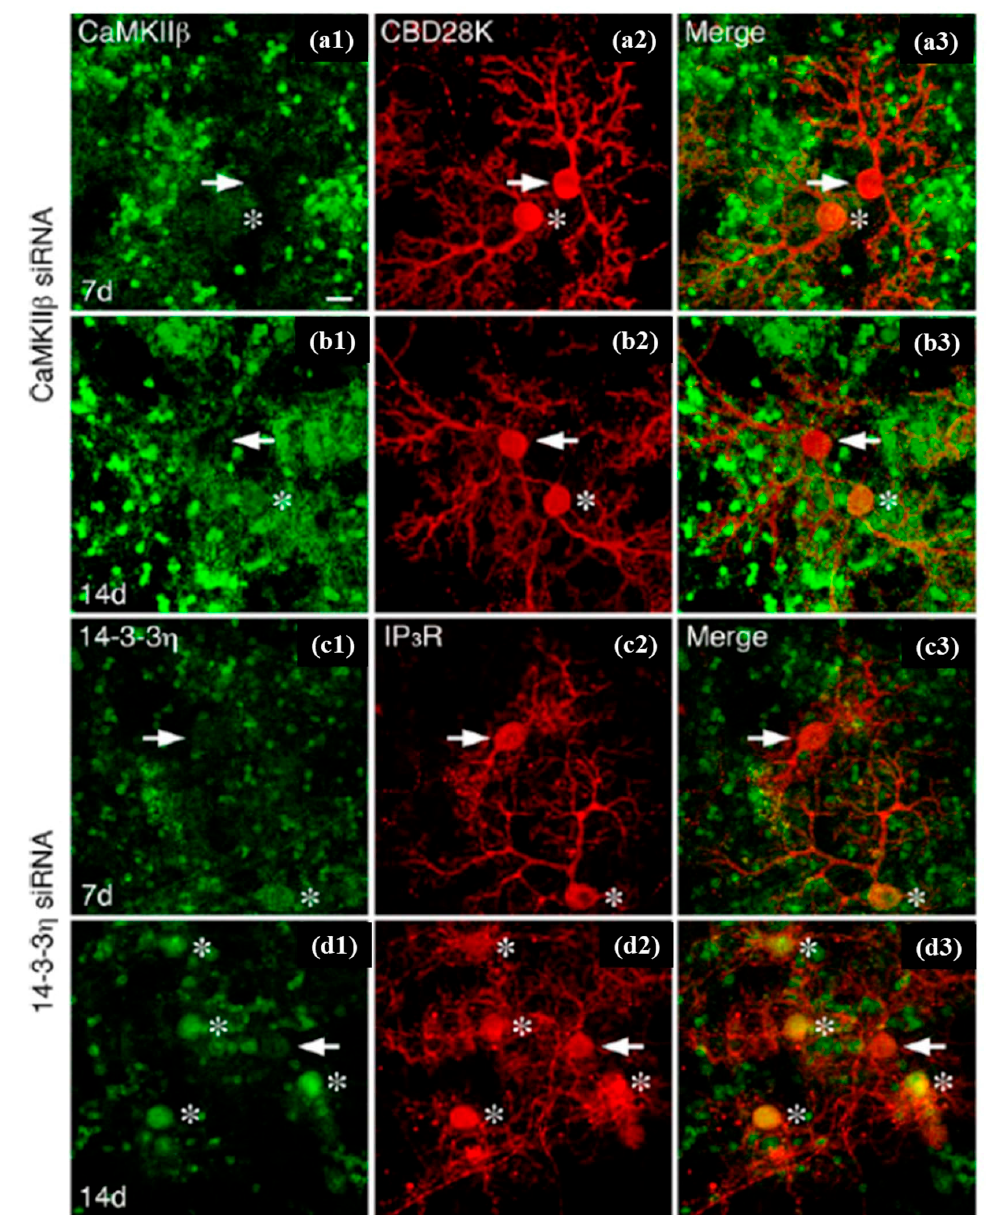
Figure 15. Immunostaining images of single-cell electroporated Purkinje cells small interfering RNA (siRNA) against calcium / calmodulin-dependent protein kinase ß (CaMKIIß) or 14-3-3 η ). SCEP was done at 11 days in vitro (DIV). The cell fixation was performed on day 7 ( a , c ) or day 14 ( b , d ) post electroporation (18 or 25 DIV, respectively) and double fluorescent immunostaining against CaMKIIß (green in a , b ) and calbindin-D-28 K (CBD28K) (red in a , b ) or 14-3-3 η (green in c , d ) and IP 3 R (red in c , d ) was performed. Therefore, 1, 2 and 3 correspond to green, red and merged stains respectively. CaMKIIß or 14-3-3 η signals decreased in electroporated Purkinje cells (arrows), but not in nearby non-electroporated Purkinje cells (asterisks). It is noteworthy that CaMKIIß and 14-3-3 η expression was present for both Purkinje cells and granule cells. Scale: 20 µ m. Reprinted with permission from